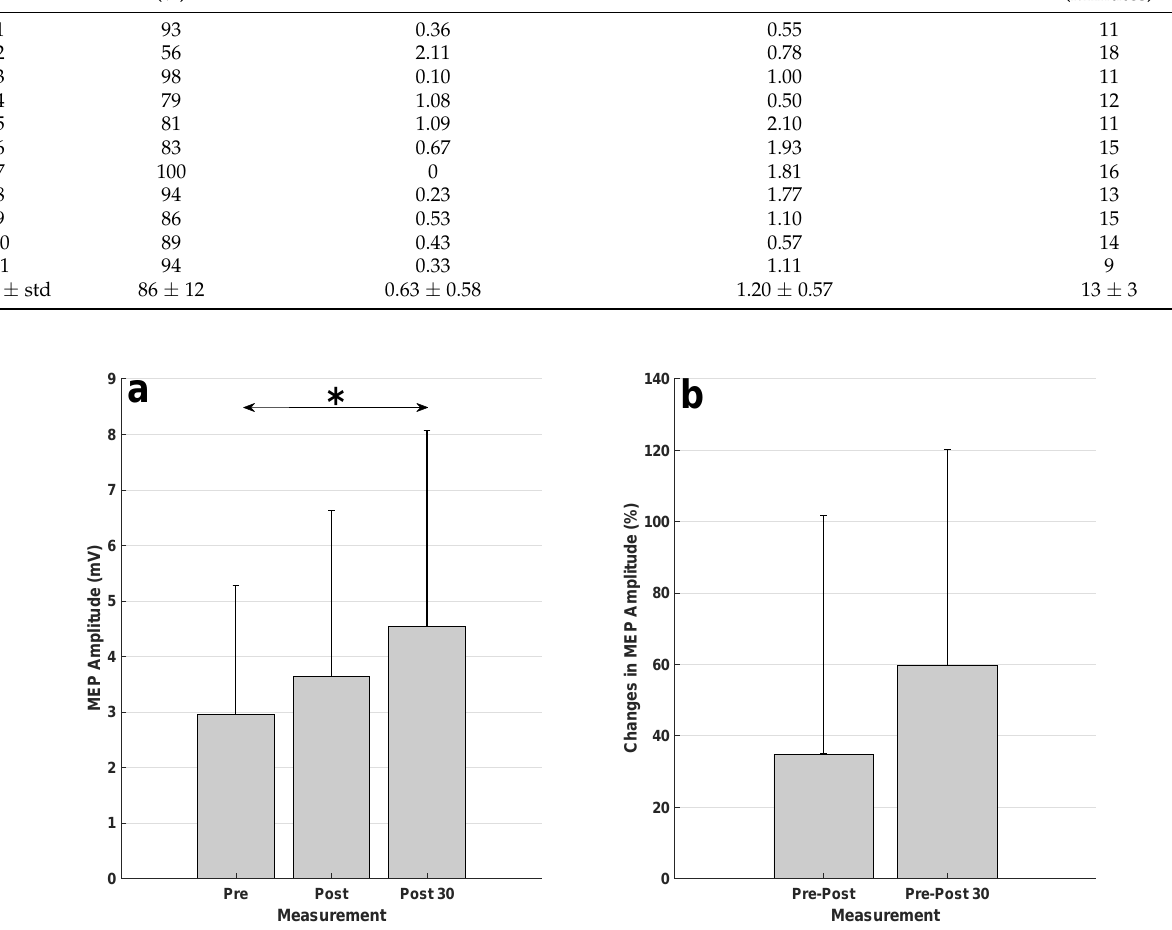
Figure 5. Summary of the MEP results. ( a ) Averaged MEP amplitudes (in mV) across the subjects, the vertical black line represents the standard deviation across subjects. The MEPs from the measurement 30 min after the intervention (Post 30) were significantly higher (denoted by *) than those from the measurement before the intervention (Pre). ( b ) MEP changes (in percent) from the measurement before the intervention to the measurement immediately after the intervention (Pre-Post) and 30 min after the intervention (Pre-Post